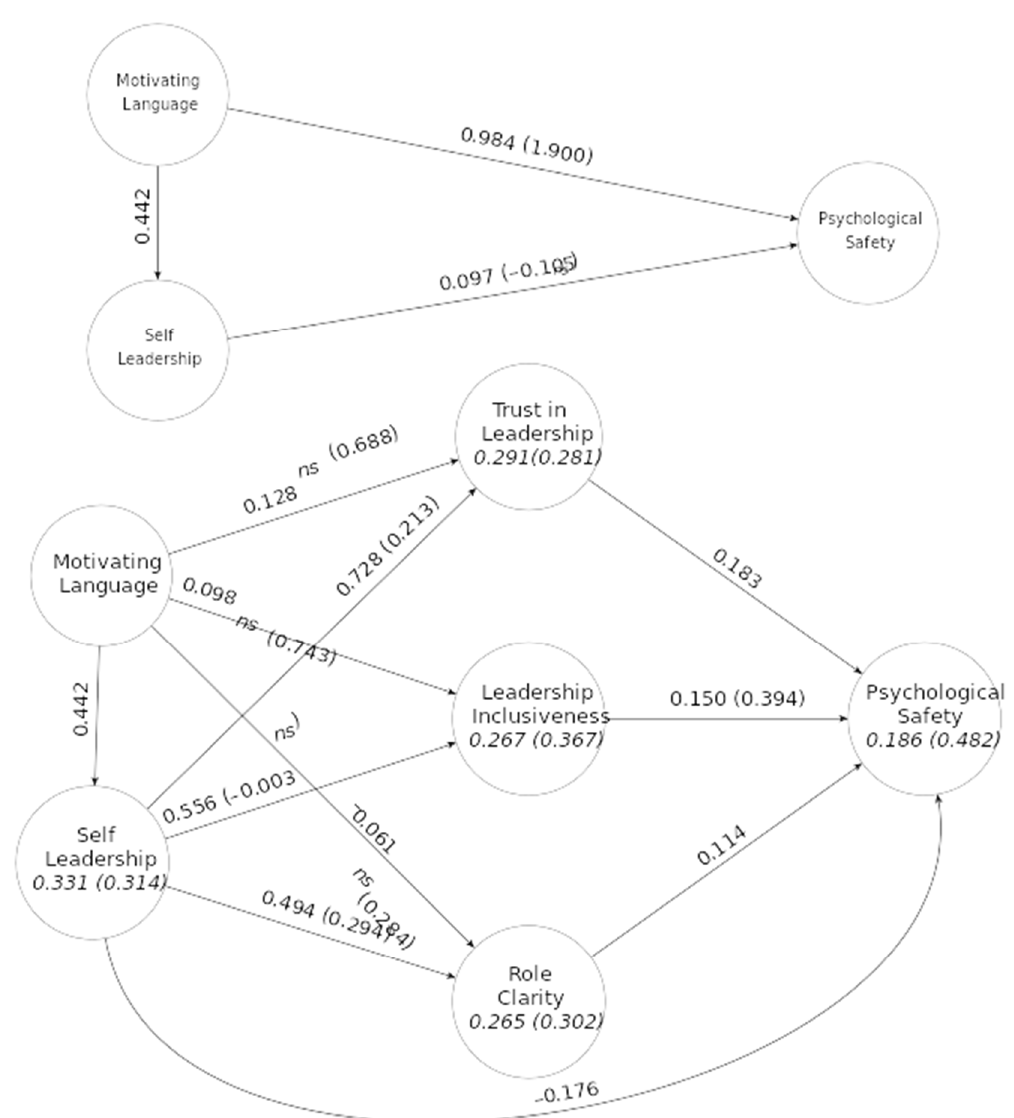
Figure 2. Model results for leader motivating language and follower self-leadership influences on follower psychological safety.